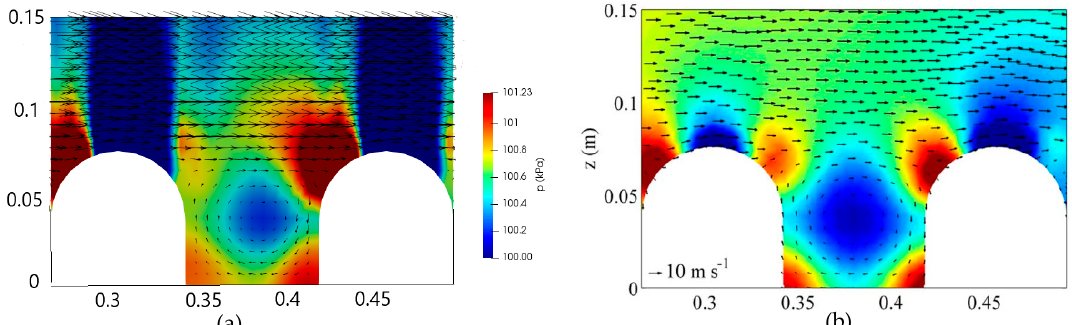
Figure 29. A comparison of the pressure distribution between numerical results obtained from our model ( left ) and Llaguno-Munitxa et al. [43] ( right ).